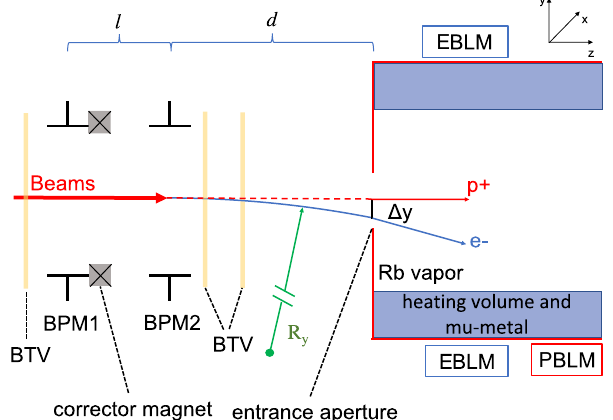
FIG. 1. Schematic of the proton and electron beam transfer line and vapor source close to the vapor source entrance. Main beam diagnostics devices are highlighted: beam-position monitors (BPMs), scintillating screens (BTVs), and electron and proton beam loss monitors (EBLMs and PBLMs, respectively). l and d are the distances between the two BPMs and between the last BPM and the vapor source entrance aperture, respectively. Beams are overlapped at the last two BPMs: The proton beam propagates essentially straight (red arrow); the electron beam trajectory (blue) is bent by Earth ’ s magnetic field with radius of curvature R . Δ y is the deviation from the straight trajectory in the vertical y plane. The drawing is not to